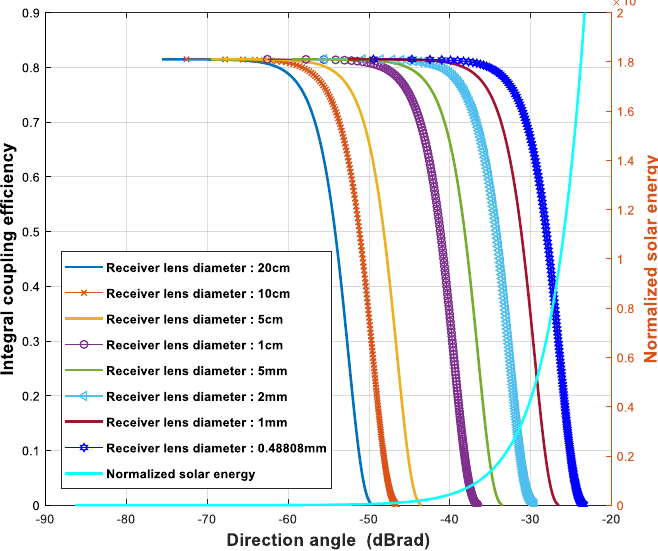
Figure 9. Curves of integral coupling efficiency vs. AL direction angle for different receiver lens diameters and normalized sunlight energy on receiver lens vs. AL direction angle.